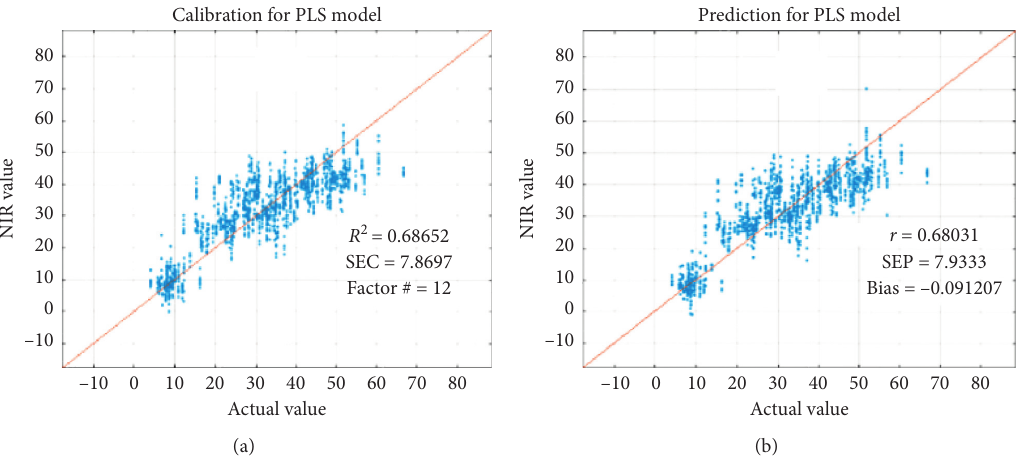
Figure 5: Measured vs. VIS/NIR values of α -solanine (mg kg − 1 ) in the calibration (a) and prediction (b) sets with PLS models. SEC: standard error of calibration; SEP: standard error of